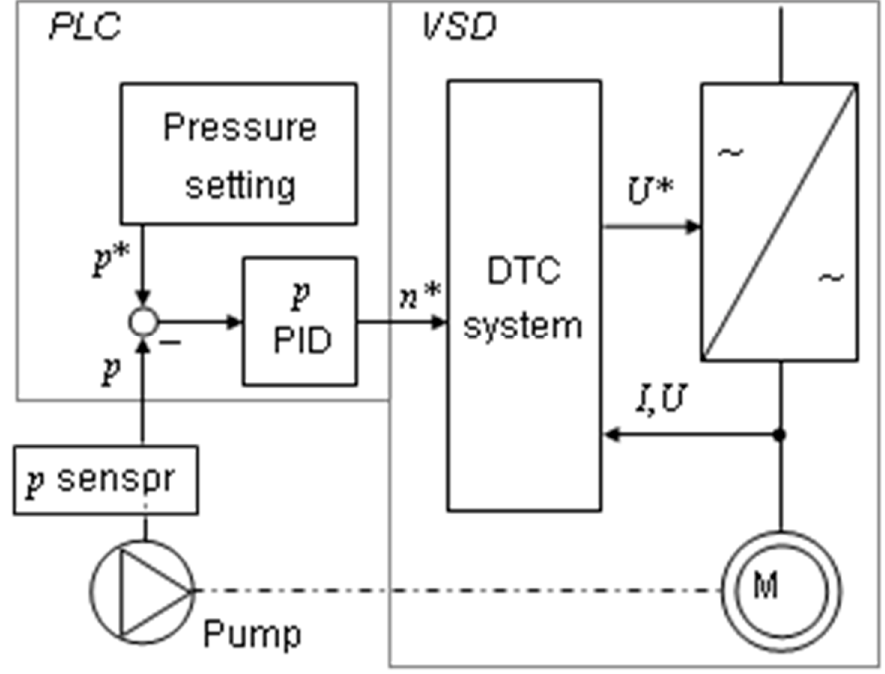
Figure 7. The DTC control of IM in pumping applications.